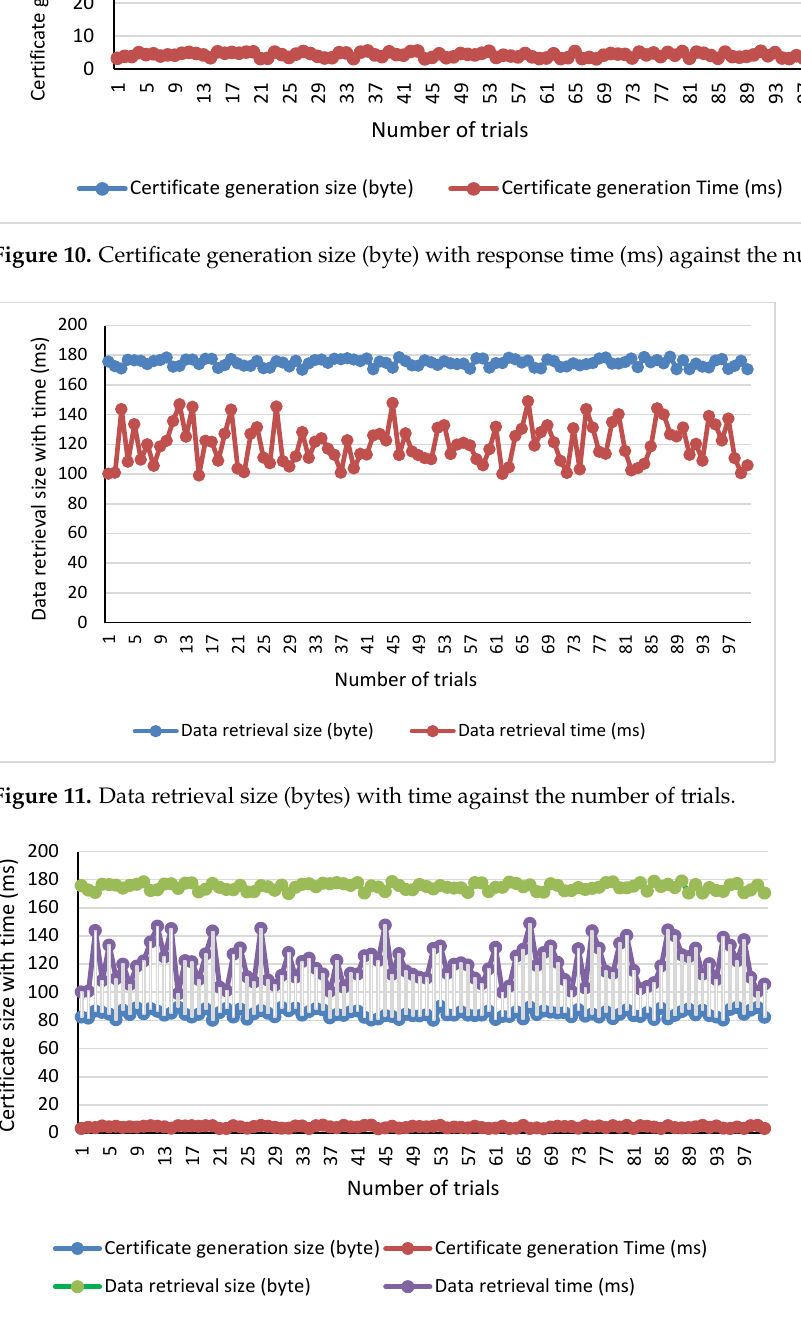
Figure 12. Comparison results of the certification latency, data retrieve latency, and data retrieval size. The performance evaluation of the proposed digital certificate was performed using the average response time and the standard deviation as the metrics. Figure 13a.